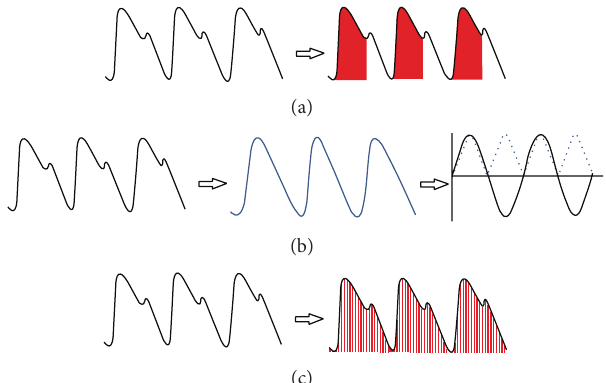
Figure 1: Different methods of arterial waveform analysis. (a) The PiCCO system utilizes the area under the curve of the systolic portion of the arterial waveform to calculate cardiac output, as depicted by the shaded area of the waveform on the right. (b) The LiDCO system uses pulse power analysis by first transforming the arterial waveform into a volume versus time waveform, as shown in the middle of the panel. Next, autocorrelation using a sine wave (solid black curve on the right of the panel) and a sine squared wave (dotted blue line on the right of the panel) estimates a nominal stroke volume, which can then be converted to cardiac output via calibration. (c) The FloTrac system samples multiple data points continuously, as depicted by the red lines. The standard deviation of the pressure data points around the mean arterial pressure is linearly related to stroke volume, which is then used to calculate cardiac